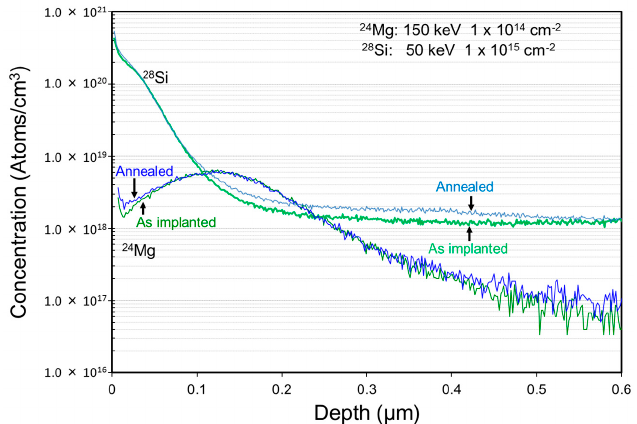
Figure 2. Ion-implanted Mg and Si profiles in a free-standing GaN substrate. Si background concentration in the substrate was about 2 × 10 18 cm − 3 .